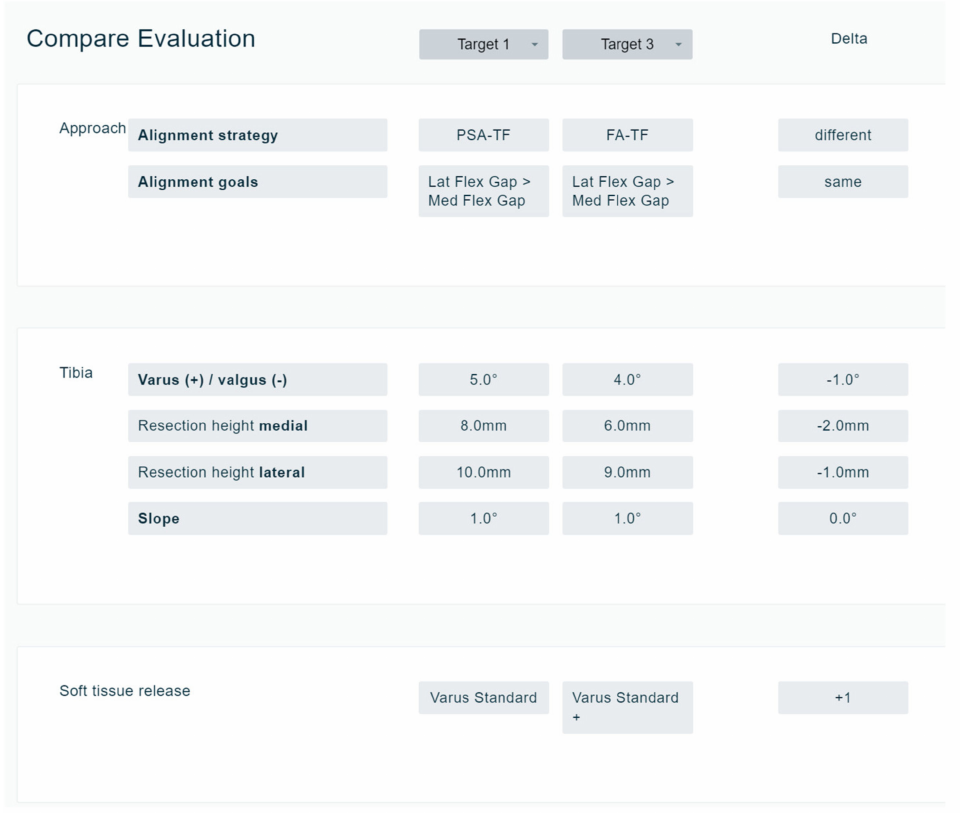
Figure 4. Comparison function. In all cases, all decisions of different alignment philosophies can be seen on one screen (in this figure, only for tibia and soft tissue). This allows a comparison of different philosophies in different cases. Here, the difference between PSA-TF and FA-TF is shown for tibia and soft tissue